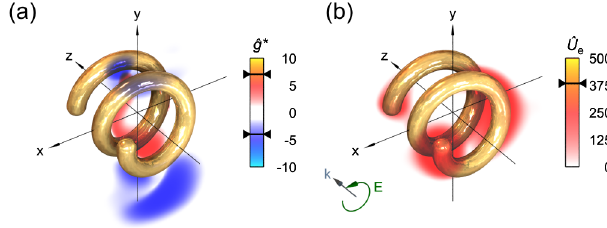
FIG. 3. (a) Enhancement of dissymmetry factor ^ g (cid:4) near a plasmonic helix structure with respect to circularly polarized light. Superchiral light fields with up to 7 times higher enantio- selectivity could be obtained. This value does not follow the enhancement of optical chirality directly, as (b) the enhancement ^ U also enters the calculation. The of electric energy density e electric energy density shows similar distributions as optical chirality, leading to more complicated shapes of the superchiral light fields. Note the different scale of the color bar related to the ^ C in Fig. plot of ^ g (cid:4) compared to the plots of